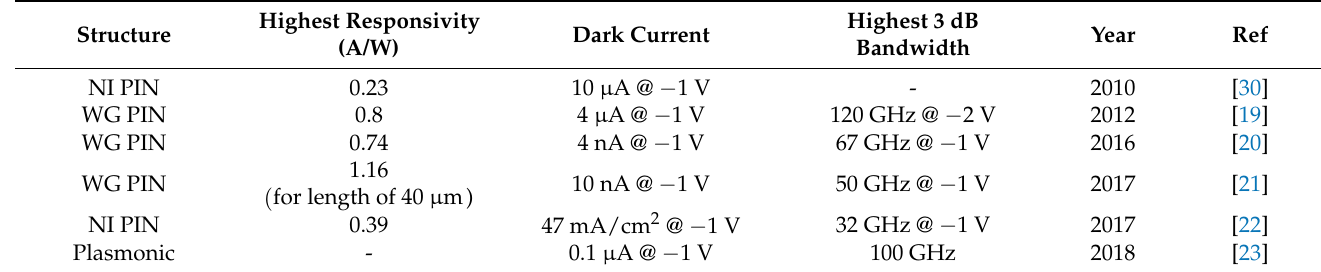
Table 1. Performance of various Ge-based photodetectors. WG and NI refer to the waveguide and normal incidence photodetectors, respectively.